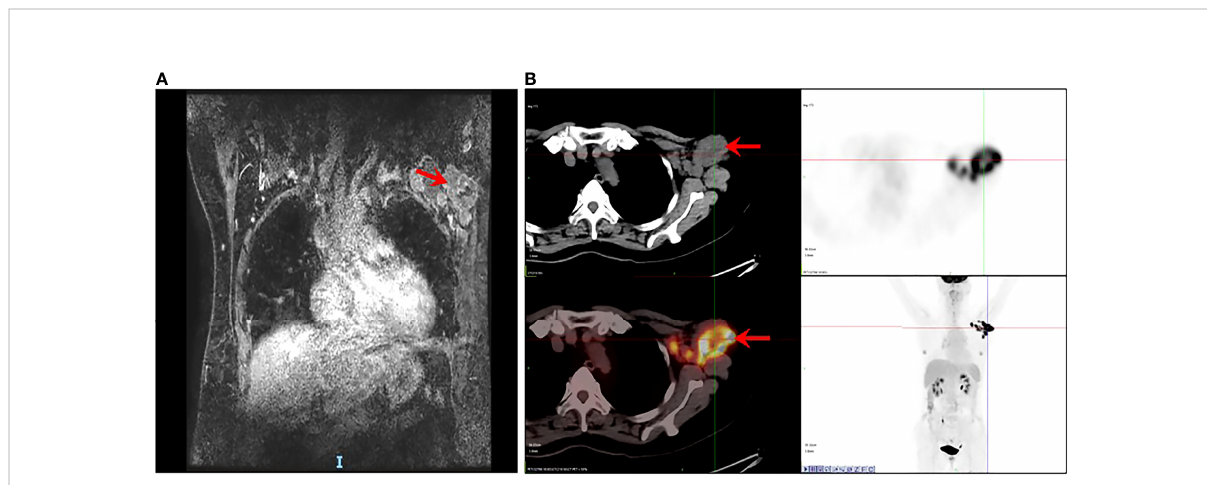
FIGURE 1 Occult breast cancer accompanied by metastasis in axillary lymph nodes. (A) MRI showing multiple enlarged and fused lymph nodes (arrow). (B) PET/CT showing multiple enlarged nodes on the deep muscles of the left axilla and the left anterior upper chest wall, radioactively concentrated (arrow) as well as with no evident metabolically active lesion in the bilateral breasts, remaining trunk, and